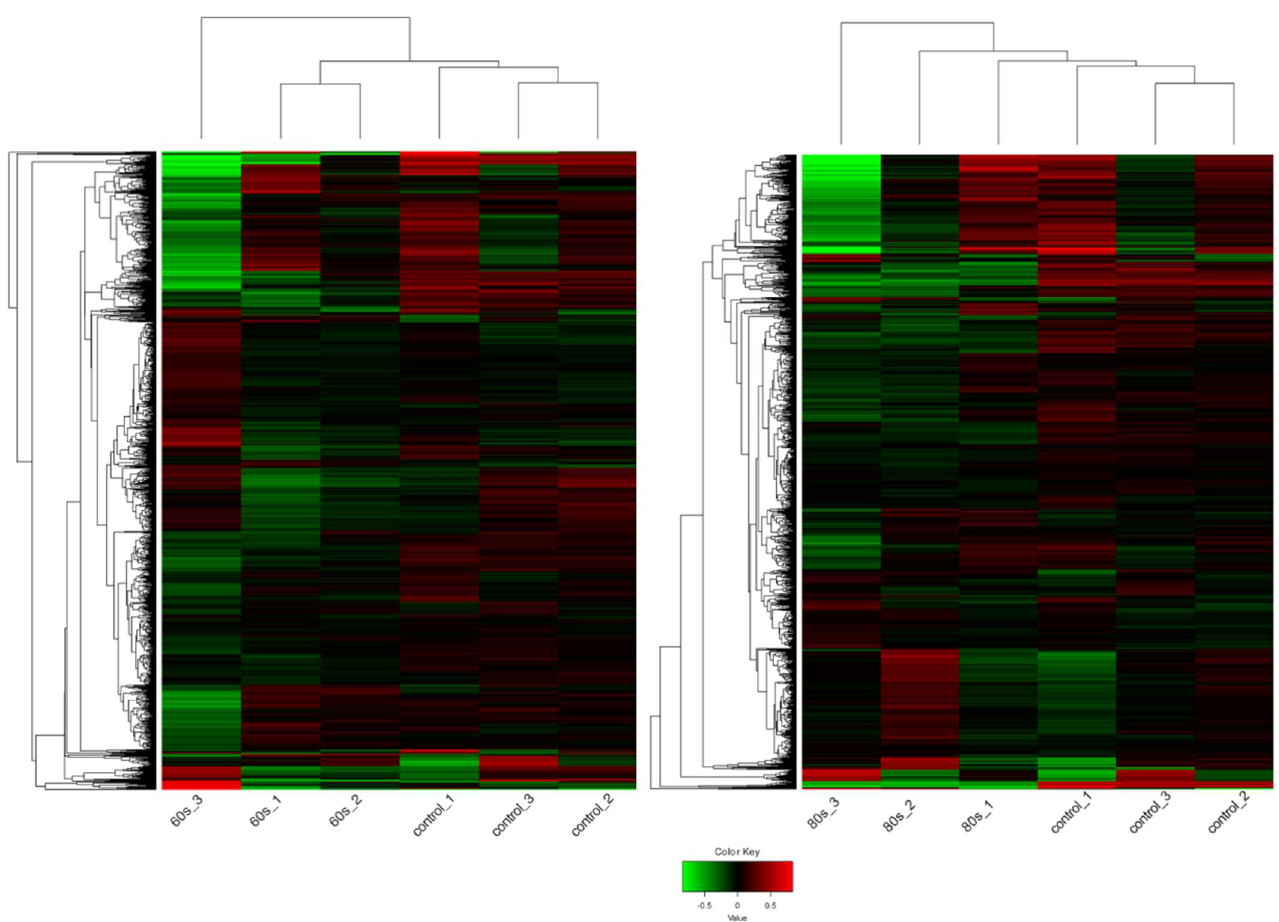
Figure 3. Heat map of the expression patterns (Z-scaled reads per kilobase of exon per million (RPKM) values) of the full transcriptome for 60 s ( left ) and 80 s ( right ). Hierarchical clustering of the relative expression profile of the top 2000 variable genes selected based on the lowest standard deviation using Euclidean distance. Individual samples are shown in columns and genes in rows. The upper axis shows the clusters of samples, and the left vertical axis shows clusters of genes. The color scale represents the relative expression of genes: green indicates low relative expression levels; red indicates high relative expression levels; black indicates zero (no change). The overall trend shows that genes are mainly downregulated after plasma exposure compared to the control, untreated samples.